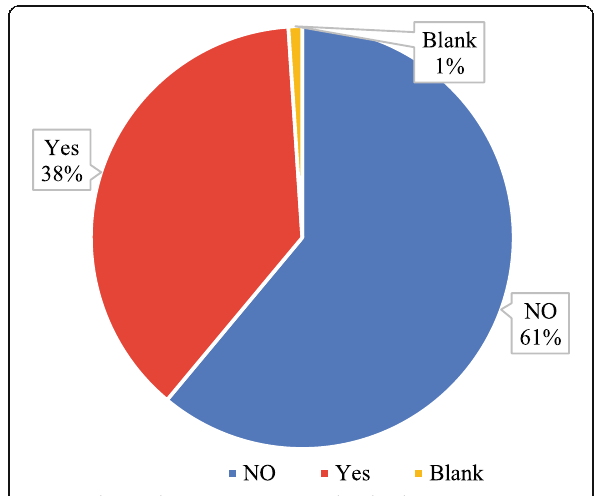
Fig. 3 Subspeciality CT scan courses taken by the participants